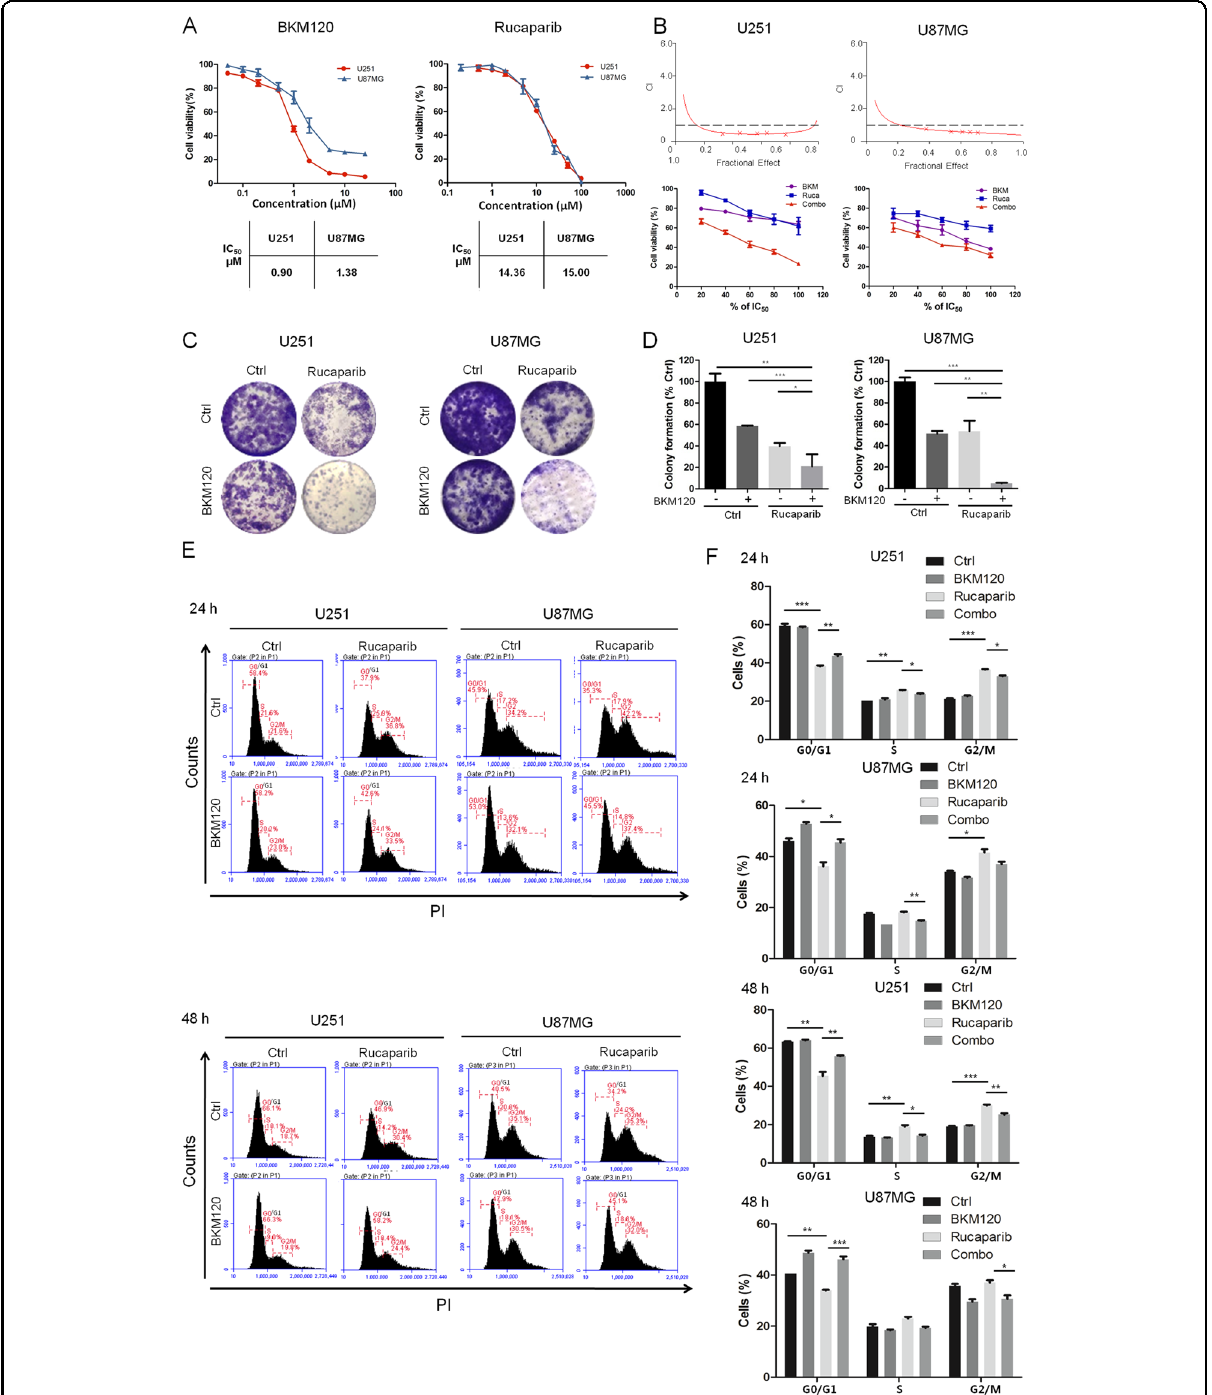
Fig. 1 The in vitro antiproliferative activities of BKM120 and/or rucaparib in human GBM cells. A U251 and U87MG cells were treated with various concentrations of BKM120 and rucaparib (BKM-120 0.05, 0.1, 0.2, 0.5, 1, 2, 5, 10, 25 μ M; rucaparib-0.2, 0.5, 1, 2, 5, 10, 25, 50, 100 μ M), and antiproliferative effects were determined by MTT assay following 96h incubation. B Cells were treated with BKM120 and rucaparib as single agents or in combination for 96h and then subjected to MTT assay. The drug combination effects were analyzed using CalcuSyn software, and the resulting CI-Fa plots are shown. C U251 cells were treated with 0.5 μ M BKM120 or/and 10 μ M rucaparib, and U87 cells were treated with 1 μ M BKM120 or/and 10 μ M rucaparib (the same concentrations were used in subsequent experiments unless indicated) for 10 days and then stained with crystal violet. D Colonies with 50 or more cells were quanti fi ed using ImageJ. E Cells were treated with BKM120 and/or rucaparib for 24/48h. After PI staining, fl ow cytometry analysis was performed to determine the cell cycle distribution. F Cell cycle distribution of the cells exposed to the single drugs or combination are represented as stacked columns. Statistical analysis of G2/M phase in each group. All data are presented as the mean±SD ( n = 3). * P <0.05; ** P <0.01; *** P